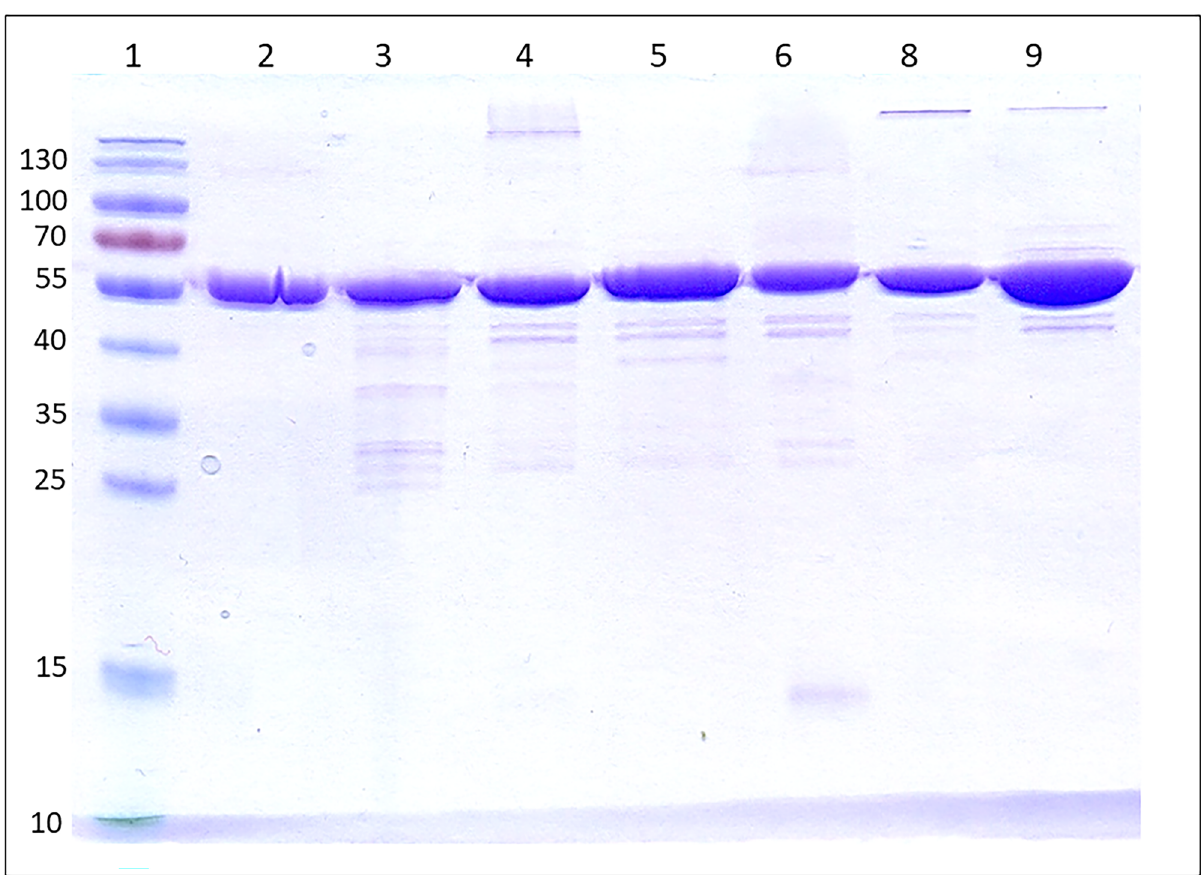
Figure 2. SDS-PAGE Coomassie staining of purified chimeric pyocins. Lane 1—PageRuler Prestained protein ladder (Thermo Fisher Scientific), lane 2—S5 (0.9 mg/ml), lane 3—S5-PmnH (0.9 mg/ml), lane